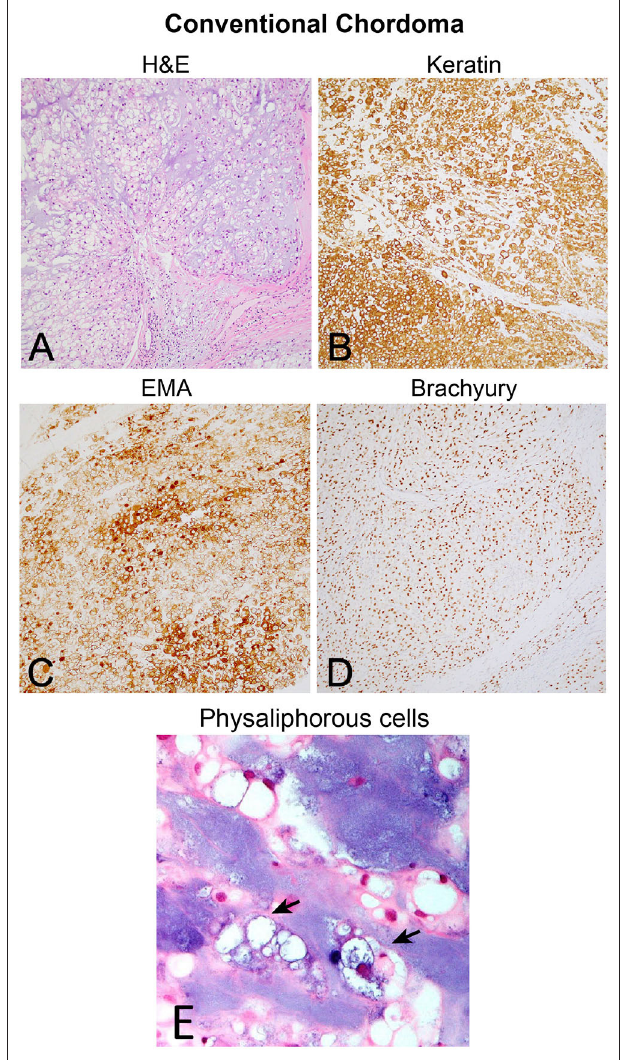
FIGURE 1 | (A) Conventional chordoma showing classic histologic features of large, epithelioid tumor cells with eosinophilic cytoplasm containing multiple vacuoles arranged in nests and cords in an overall lobular growth pattern. Tumor cells are reliably positive for (B) keratins and (C) EMA. S100 staining may be seen in select cases but is not ubiquitous (not shown). (D) Nuclear positivity for brachyury is highly specific and observed in the vast majority of cases. (E) Physaliphorous cells (arrows) display abundant, “bubbly” cytoplasm with small, round nuclei on higher magnification. Large and small cells can be seen in the background of blue, myxoid